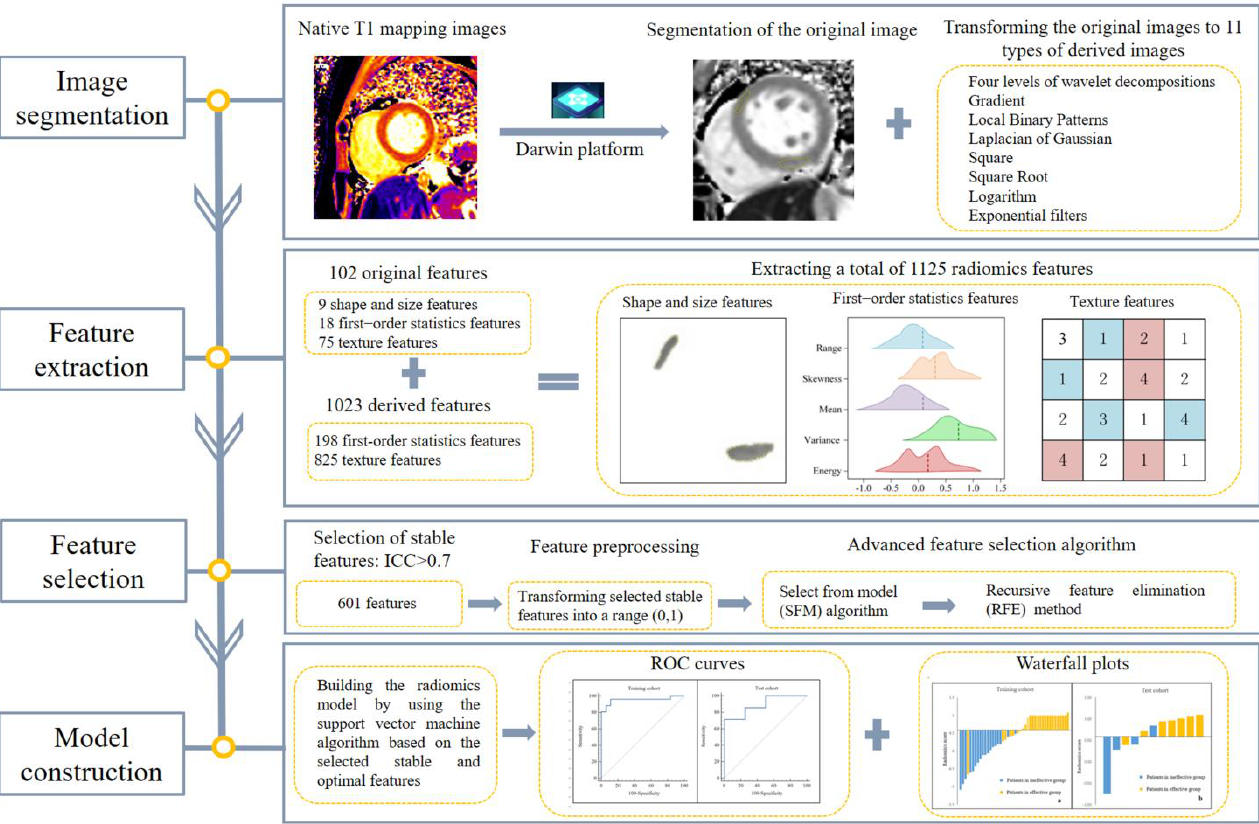
Figure 2. Workflow of the radiomics model